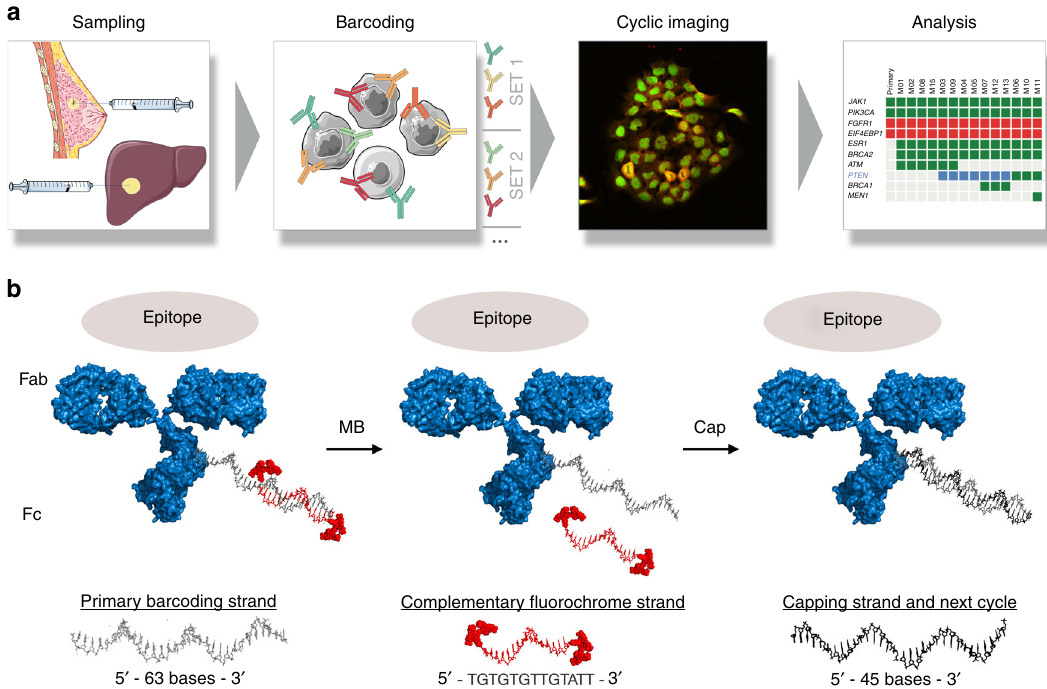
Fig. 1 Overview of the method. a Cells obtained by image-guided fi ne needle aspiration are immersed in fi xative, semi-permeabilized, and interrogated with antibody – DNA conjugates hybridized to complementary imaging strands that fl uoresce in different channels. This cycle is repeated until all targets of interest are imaged. Automated image analysis allows graphing of data in analytical formats. b Barcoding approach. A 63 bp primary barcoding strand is attached to an antibody of interest using maleimide chemistry. In vitro, complementary imaging strands consisting of 13 bp and two fl uorochromes are used to obtain fl uorescent mAb – DNA conjugates. Cocktails of such antibodies with different fl uorochromes (Paci fi c Blue, AF488, AF594, AF647) are then used to stain cells. After imaging, the fl uorescent strands are simply washed off with melting buffer and the primary strands are capped to reduce additional cycle-to-cycle